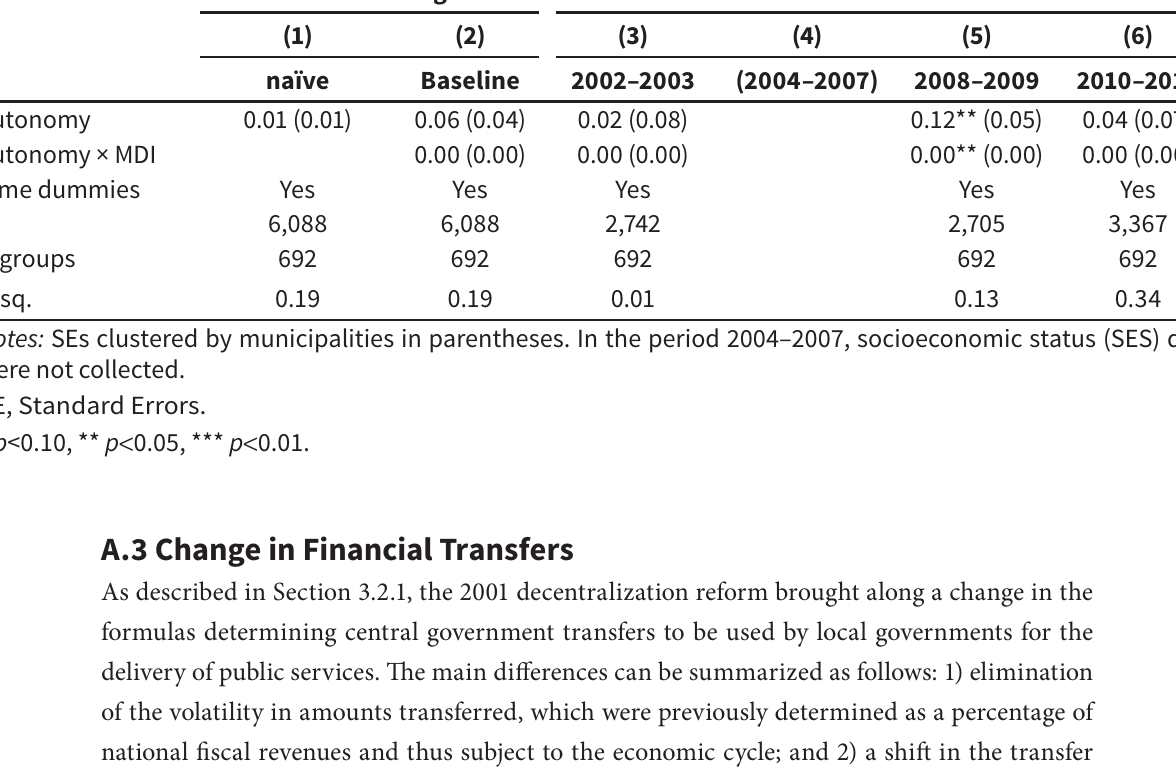
The effect of municipal autonomy on share of low-SES test takers Period